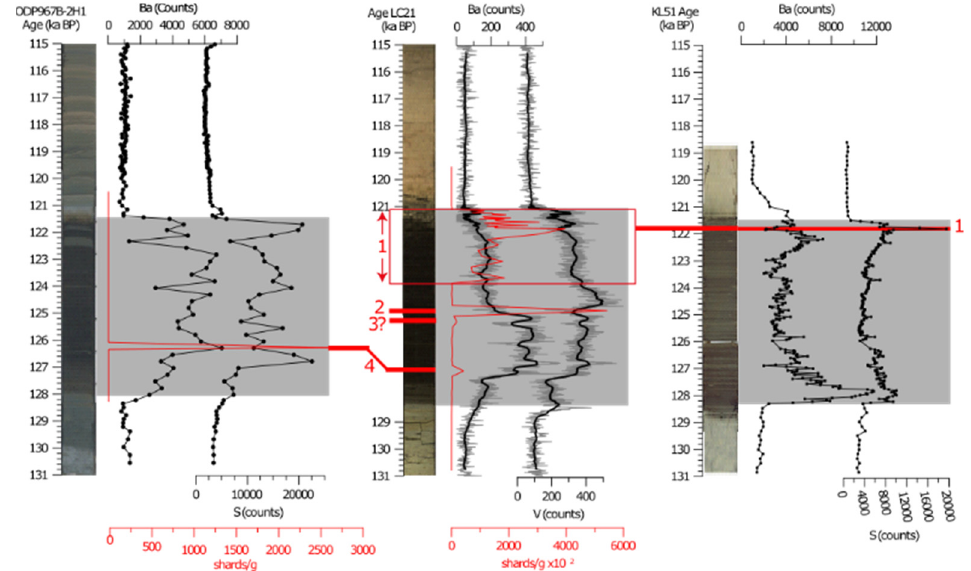
Figure 7. Chronology of sapropel S5 and tephra layers (red lines) in Eastern Mediterranean marine cores ODP967B-2H1, LC21, and KL51. All records as in Figure 2, but plotted against age instead of depth following the sapropel chronology of [22,54]. LC21 age scale within the sapropel is not shown, due to possible changes in the sedimentation rate in this core; see text for discussion. Numbered red lines (1, 2, 3? and 4) indicate proposed tephra layer based on the major element glass chemistry and relate to the numbers of the data clusters defined by the DFA (Figure 6). Tephra 1 in LC21 is shown over a range of depths (red box) reflecting the depth uncertainty of the correlation with KL51 346.8; the analyses of all tephra samples within this red box in LC21 (899.5, 941.5 and 959.5 cm) are indistinguishable from one another. Tephra layer 2 is represented by sample LC21 970.9 (visible), tephra layer 3? is a possible eruption event represented by sample LC21 975.5 and tephra layer 4 is represented by samples ODP967B-2H1 129.5 and LC21 993.5. Shard, Ba and V counts in LC21 have been aligned to the KL51 core on the cautious interpretation that sample LC21 941.5 is synchronous with the KL51 346.8 (visible) tephra; see supplementary information for discussion.